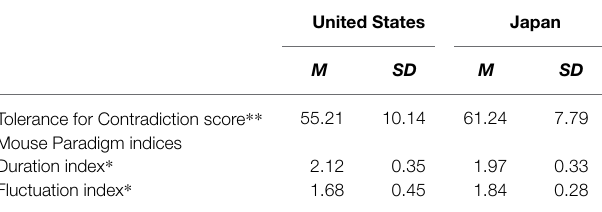
TABLE 1 | Means and standard deviations of Tolerance for Contradiction score and mouse paradigm indices by